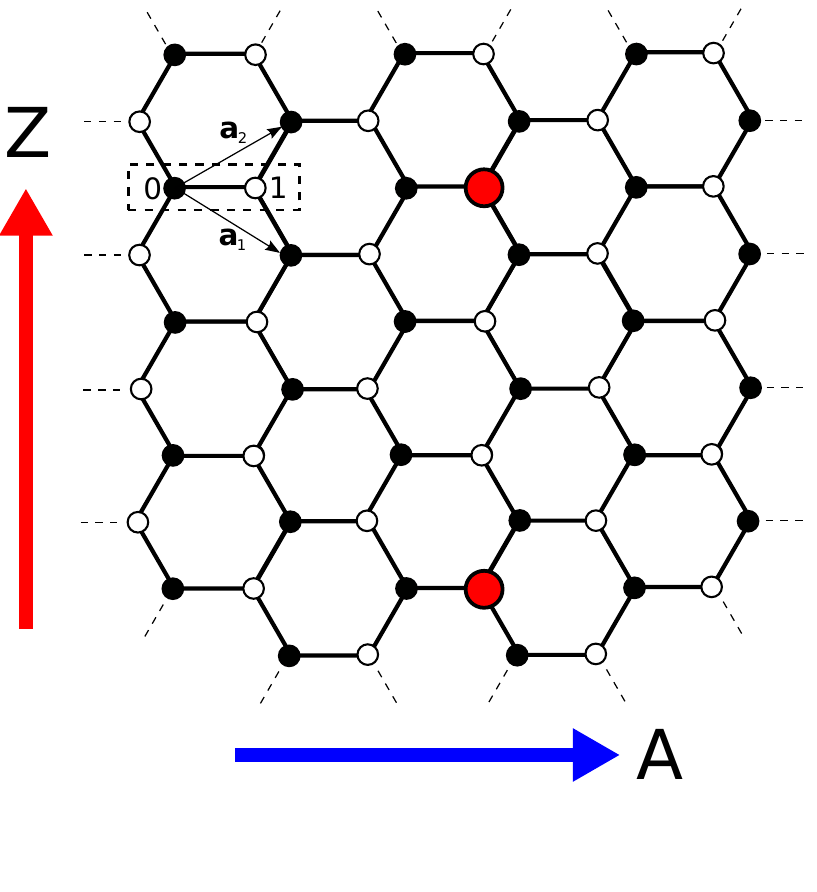
Figure 1. Schematic illustration of two substitutional magnetic impurities (red circles) embedded in a graphene lattice. Also shown are the high symmetry armchair (A) and zigzag (Z) directions, and the two-atom unit cell and lattice vectors a triangular sublattices are represented by filled and hollow